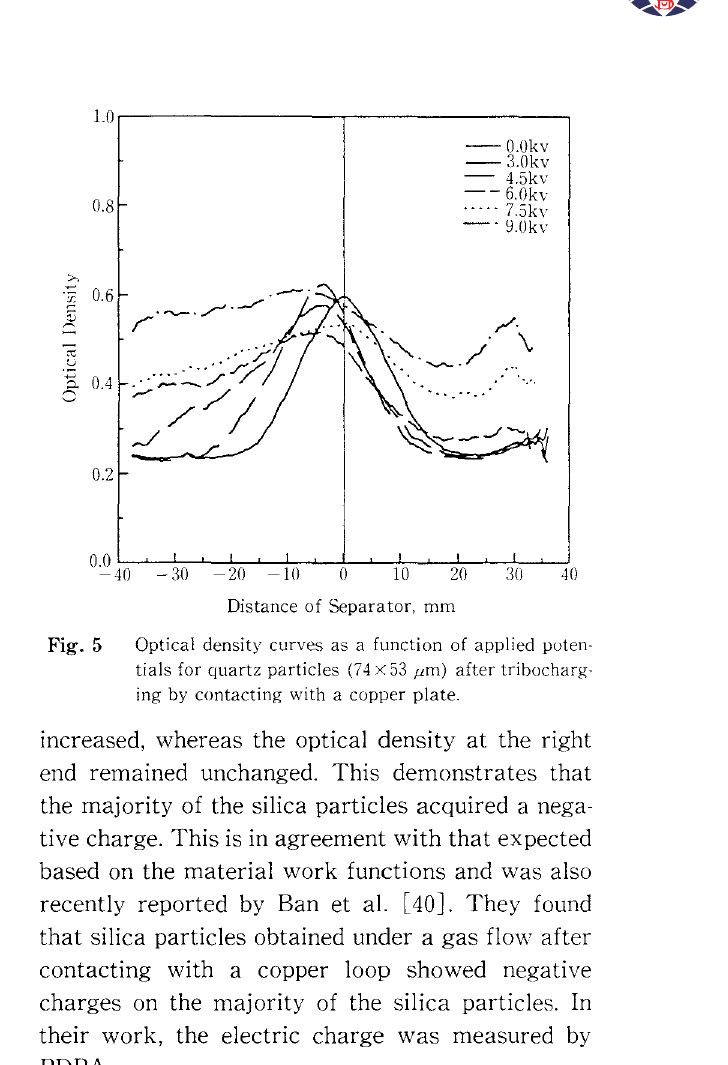
Optical density curves as a function of applied poten· tials for quartz particles (74 x 53 ,urn) after tribocharg· ing by contacting with a copper